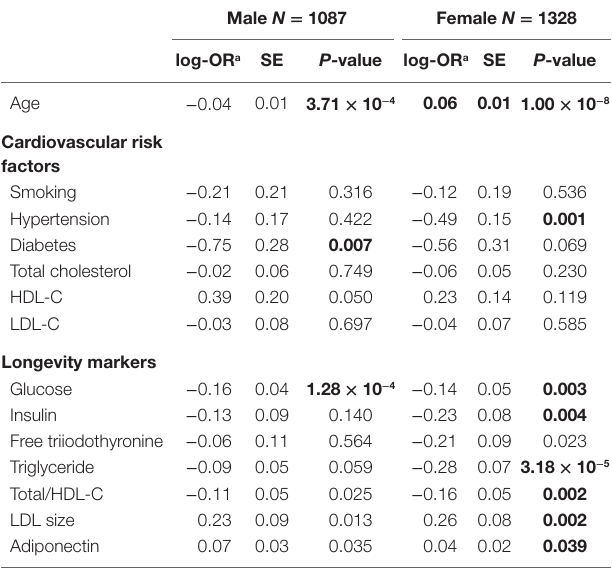
TaBle 2 | Univariate association of cardiovascular risk factors and longevity markers with longevity as offspring-control allocation in the leiden longevity study.